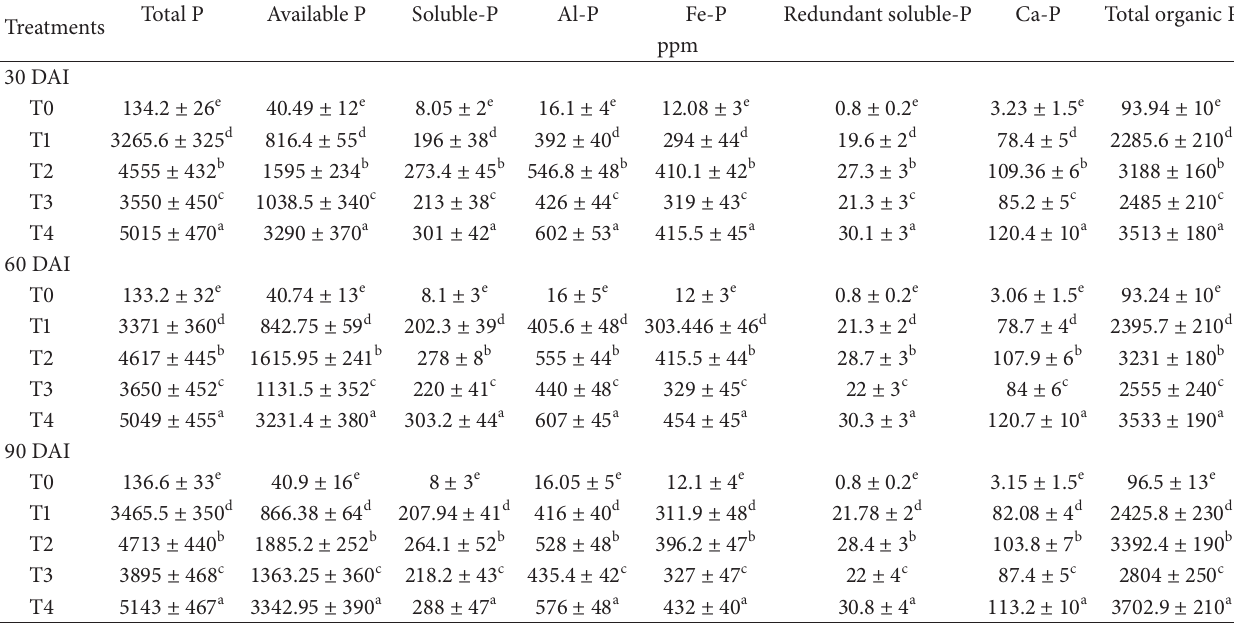
Table 6: Effects of organic amendments and incubation time on the soil total P, available P, soluble-P, Al-P, Fe-P, redundant soluble-P, Ca-P, and total organic